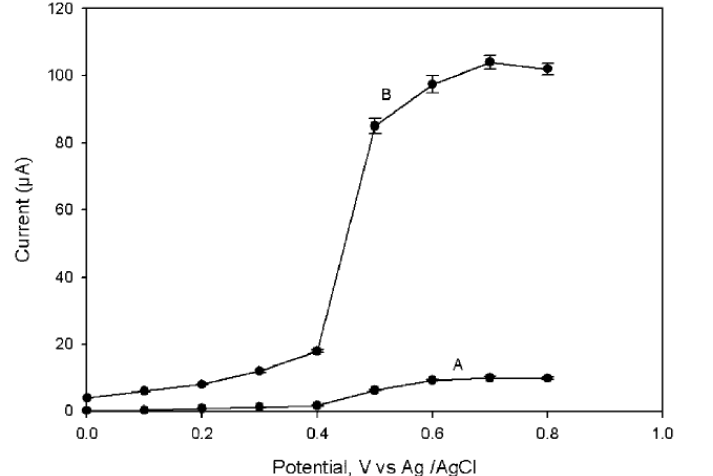
Figure 2. Hydrodynamic voltammogram for 2 x 10 -3 M thiocholine at (A) unmodified SPE and (B) MWCNTs modified SPE in 50mM phosphate buffer solution (PBS) containing 0.1 M KCl, pH 7.4 (reproduced with permission from Joshi et al.